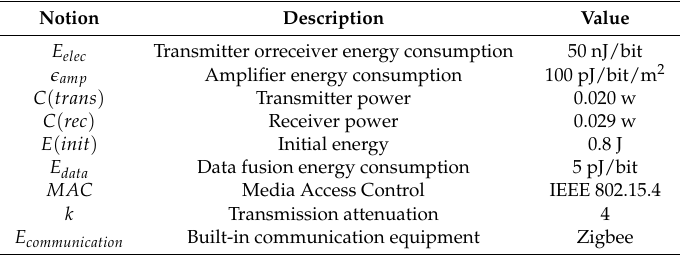
Table 4. Additional parameters in